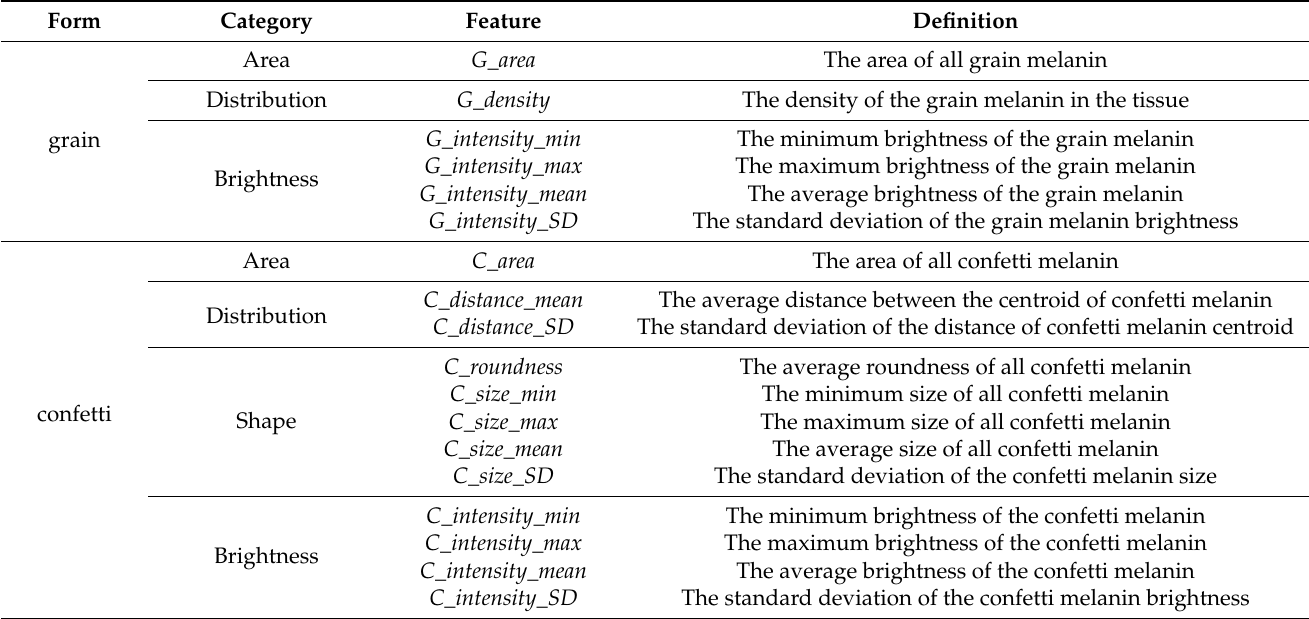
Table 1. Quantitative features of melanin-related objects on E-scan OCT